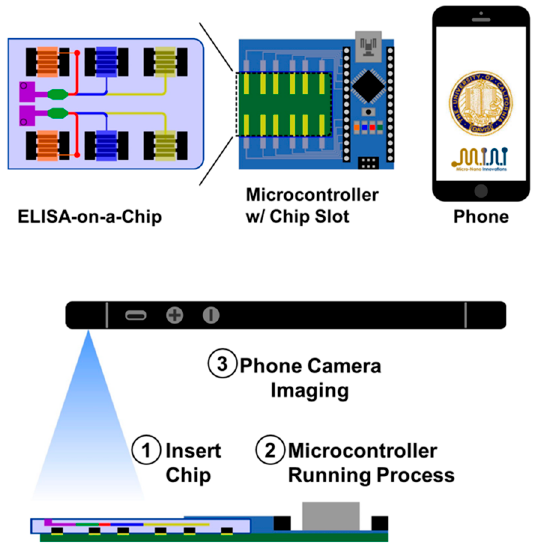
Figure 4. Schematic of the integrated mobile-interfaced diagnostic platform developed by Chen et al. Reprinted from [18], with the permission of AIP Publishing.